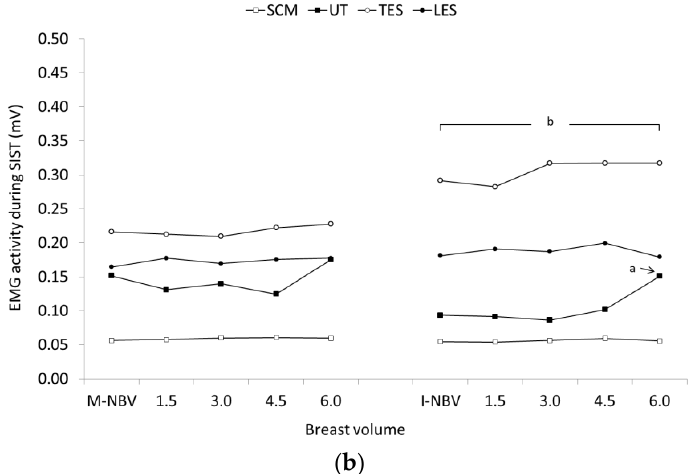
Figure 5. ( a ) Sit-to-Stand (SIST); ( b ) Geometric means and confidence intervals (error bars) of the sternocleidomastoid (SCM), upper trapezius (UT), and thoracic and lumbar erector spinae (TES and LES) EMG activity in females with minimal and ideal natural breast volume (M-NBV, I-NBV) as well as with increased NBV by 1.5-, 3.0-, 4.5- and 6.0-times during sit-to-stand (SIST). a significant different (SD) compared to females with I-NBV ( p < 0.05), 1.5- ( p < 0.05), 3.0- ( p < 0.01) and 4.5-times ( p < 0.05) the I-NBV for UT; b SD compared to females with M-NBV, 1.5-, 4.5- and 6.0-times the M-NBV ( p ≤ 0.05) for TES.